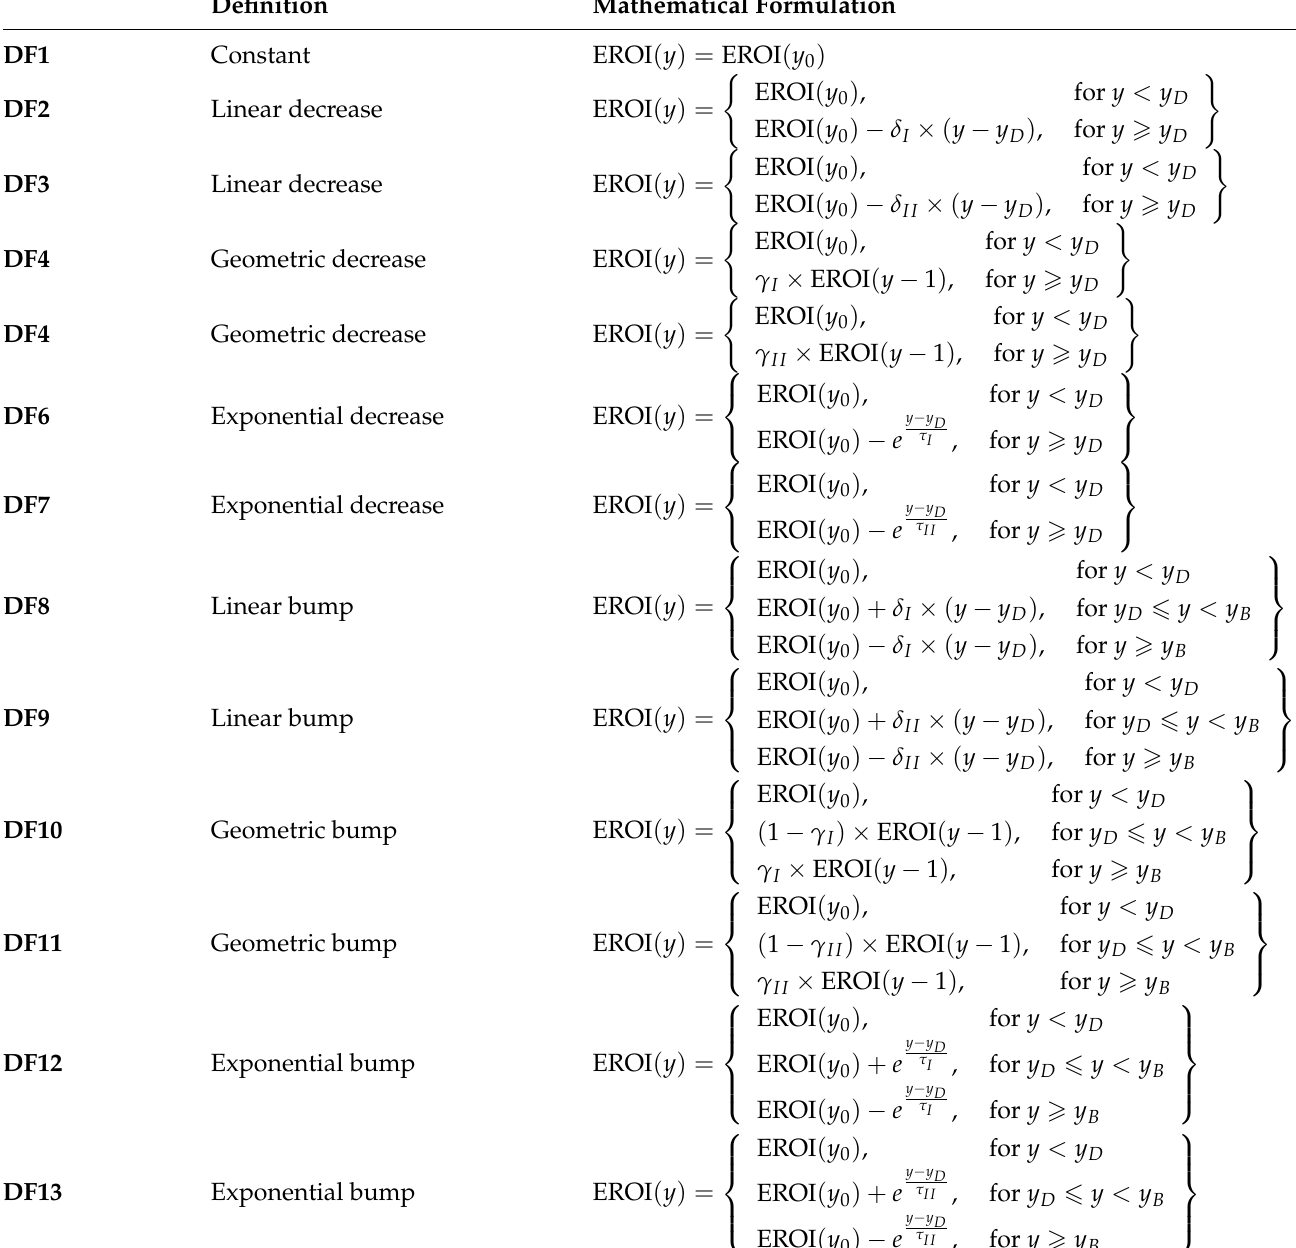
Table 5. Summary of EROI dynamic functions (DF), with EROI ( y ) 0 being the initial EROI value at the year 1950. They apply as long as EROI ( y ) is greater or equal to 1, which is the minimum value EROI can hypothetically